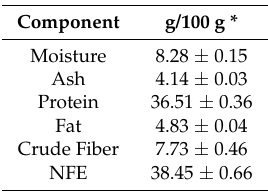
Table 1. Chemical composition of mesquite ( Prosopis laevigata ) seed